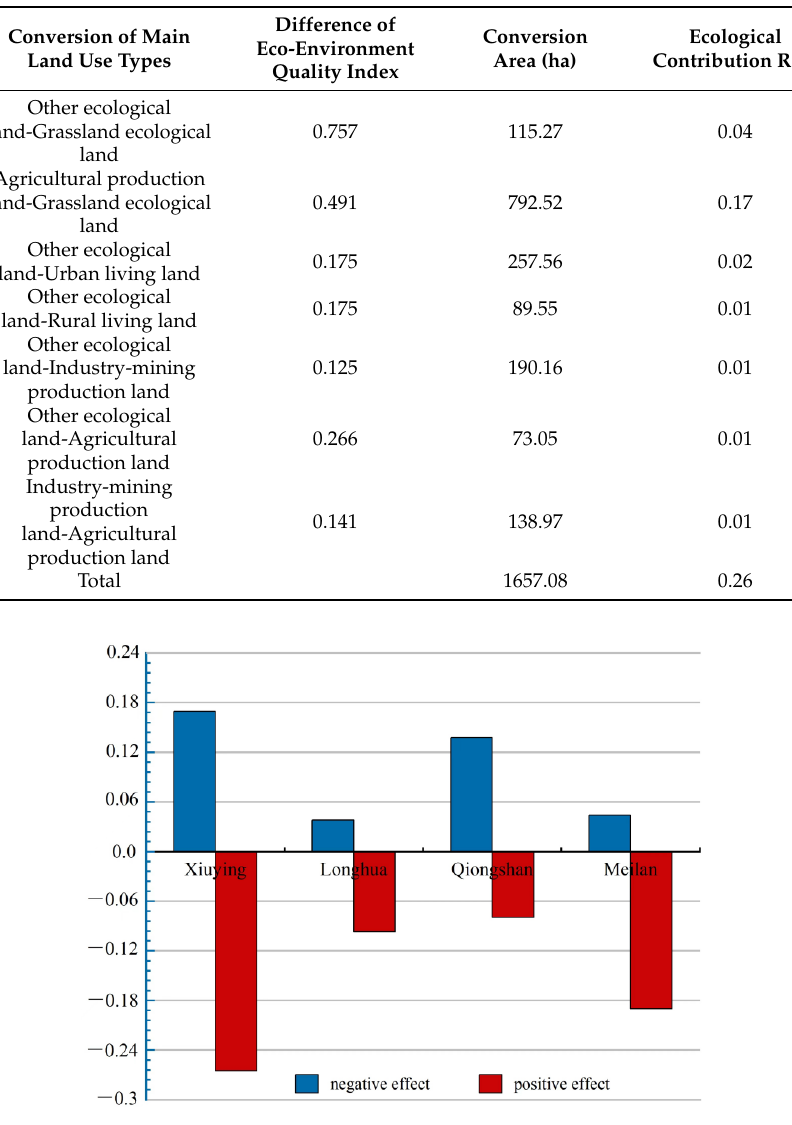
Figure 10. Ecological effects of land use function transition in Haikou from 2009 to 2018.